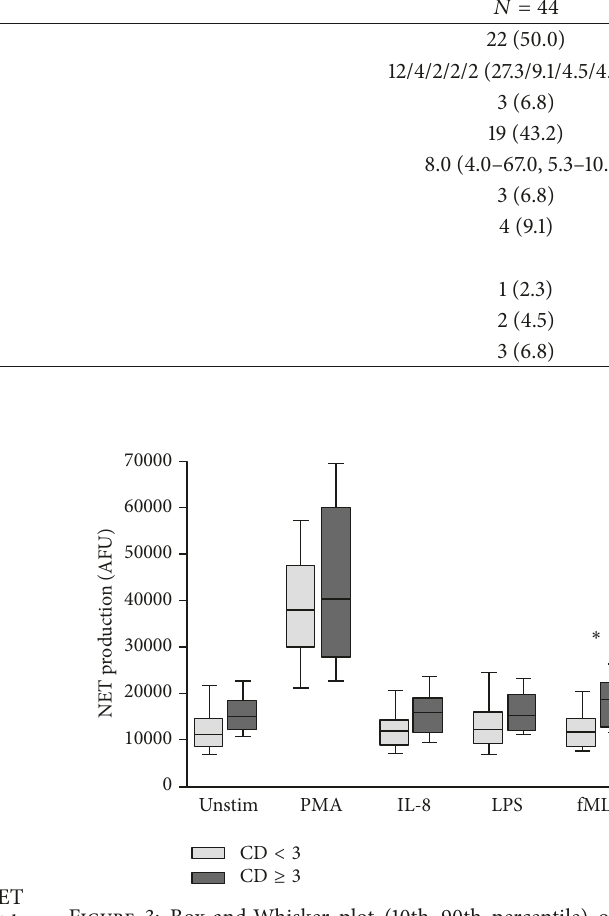
Figure 3: Box-and-Whisker plot (10th–90th percentile) of NET production in patients with Clavien-Dindo classification < 3 ( 𝑛 = 38 ) versus Clavien-Dindo classification ≥ 3 ( 𝑛 = 6 ) in response to no stimulant (Unstim), PMA, IL-8, LPS, and fMLP. Statistical significance,measuredbyMann–Whitney 𝑈 test,isdenotedby ∗ 𝑝 < 0.05